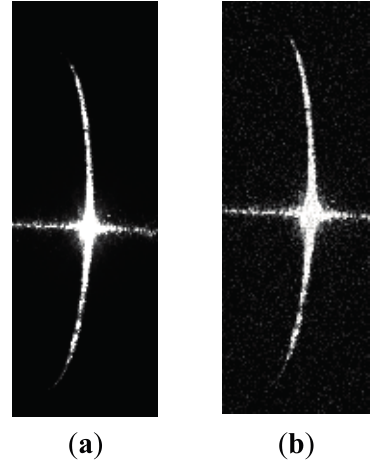
Figure 13. Images of stripe on shaft 1. ( a ) normal; ( b ) added noise.